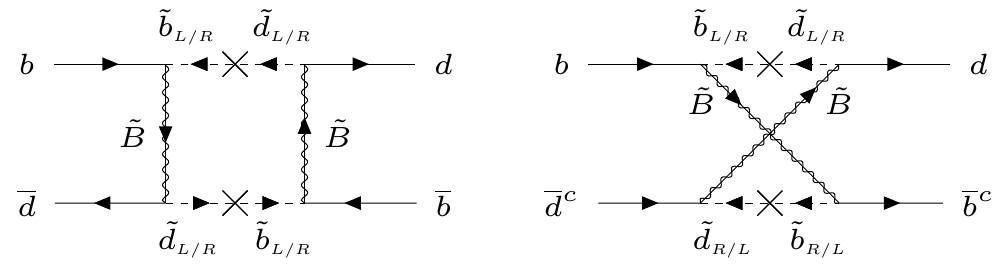
Figure 9. Diagrams mediated by Dirac binos and involving squark mass mixing which contribute to neutral meson oscillations. The case of the B 0 are analogous with the obvious substitutions. Note that only L mixing is allowed by the R -symmetry. Propagator arrows indicate the (cid:13)ow of baryon